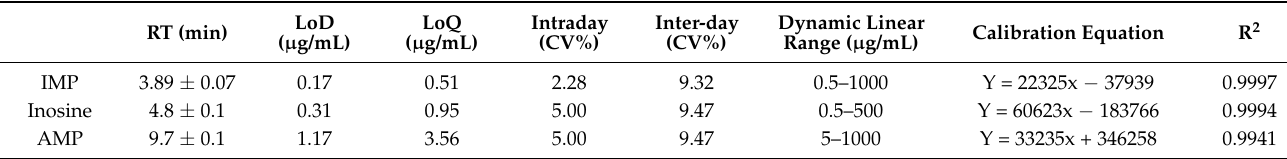
Table A2. Analytical performances of nucleotide